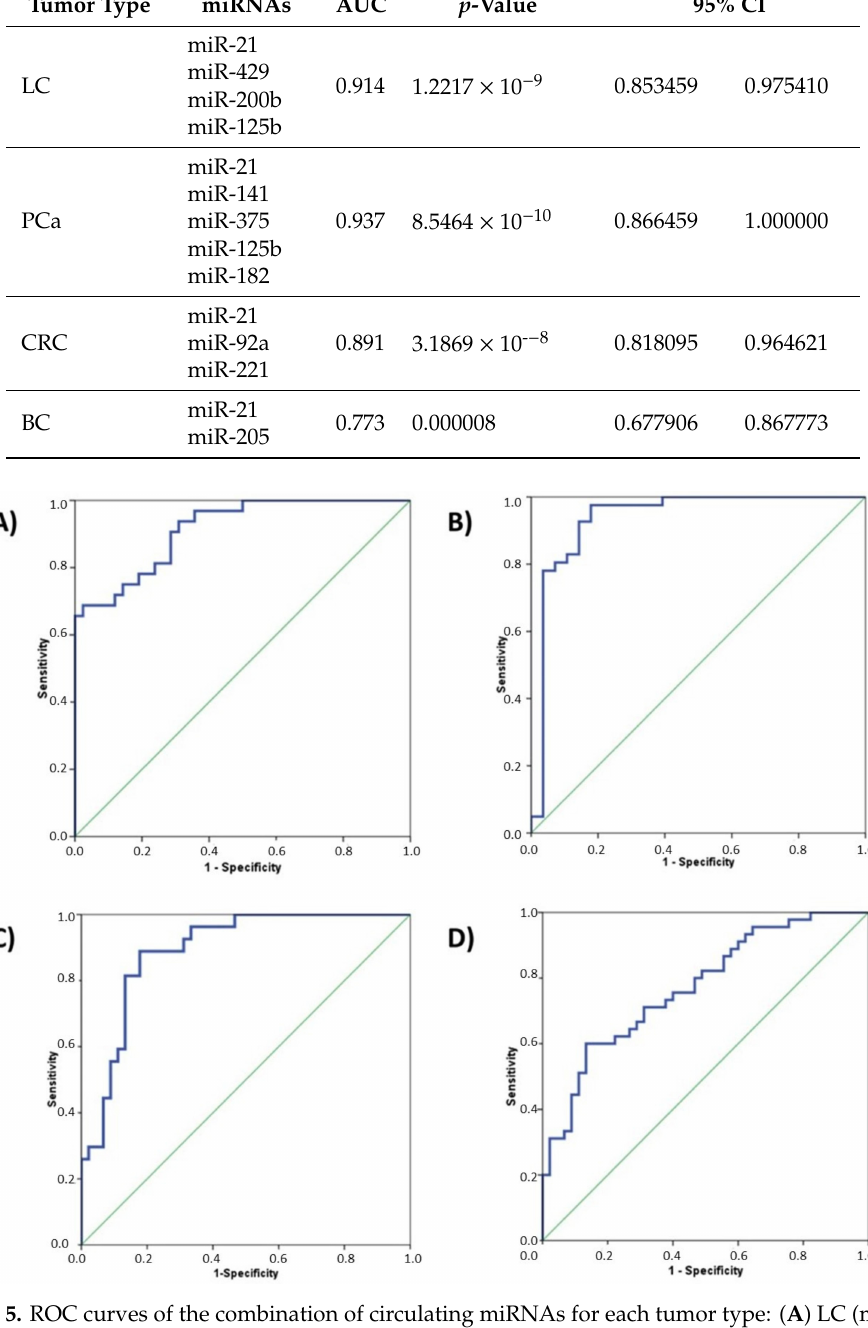
Figure 5. ROC curves of the combination of circulating miRNAs for each tumor type: ( A ) LC (miR-21, miR-429, miR-200b, and miR-125b); ( B ) PCa (miR-21, miR-141, miR-375, miR-125b, and miR-182); ( C ) CRC (miR-29a, miR-210, miR-200c, and miR-155); and ( D ) BC (miR-21 and miR-205). ROC curve calculated is represented with blue line and green line is used as a